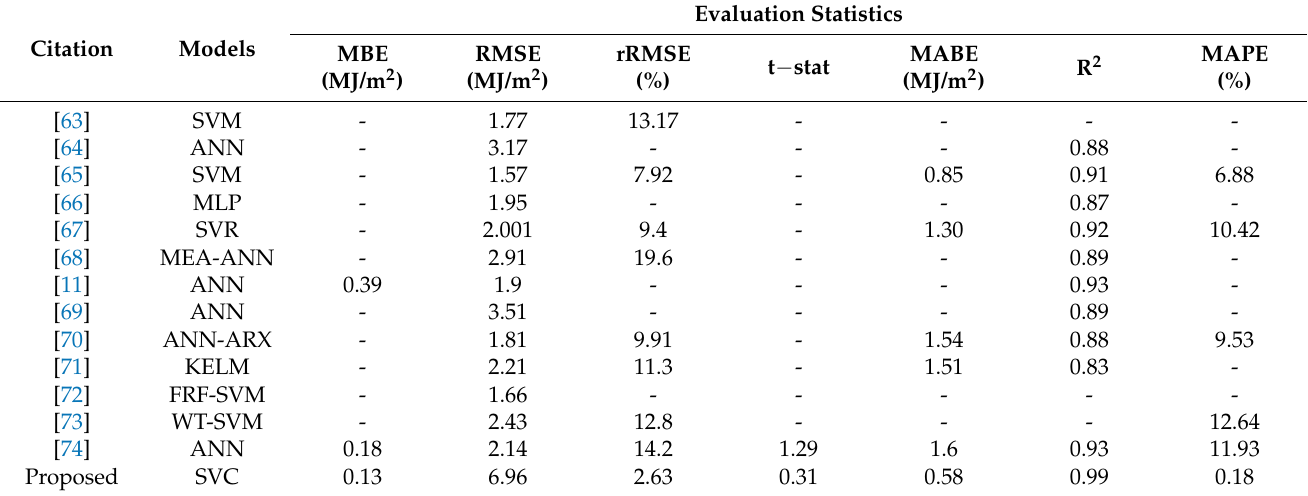
Table 4. Comparison of the statistical metrics for GHI with existing